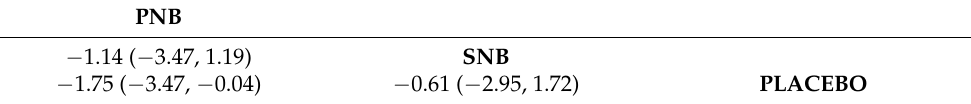
Table 3. Comparisons of interventions for reduction of the severity of ISP during the first 24 h after surgery in network meta-analysis.